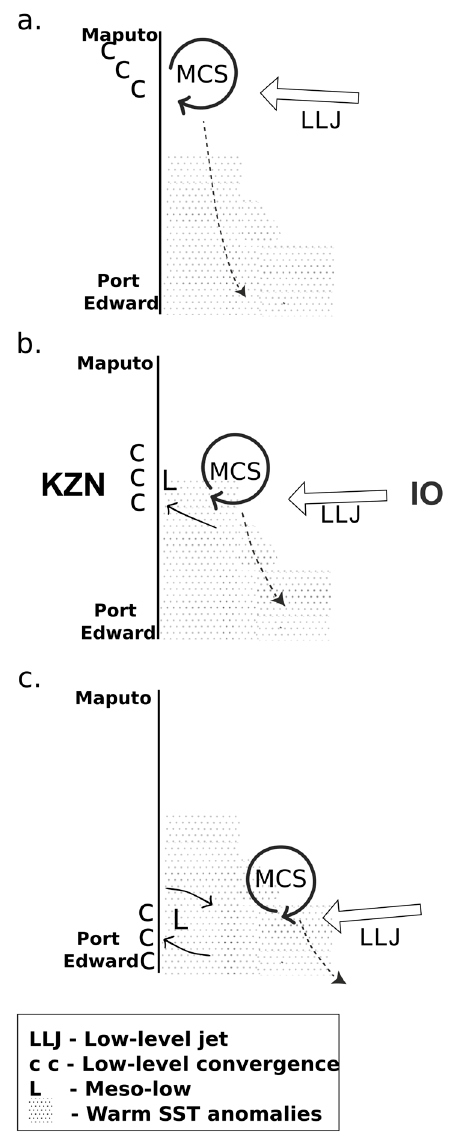
Figure 10. Schematic summarising the key mesoscale features of the event during ( a ) early on 11 April; ( b ) night of 11–12 April and ( c ) later on 12 April 2022. The vertical line represents the coastline in each panel while the dashed arrow indicates the southward and offshore movement of the MCS during the event. The abbreviation ‘IO’ stands for Indian Ocean. Note that strongest uplift occurs where there is maximum low-level convergence, denoted by C in the schematic.